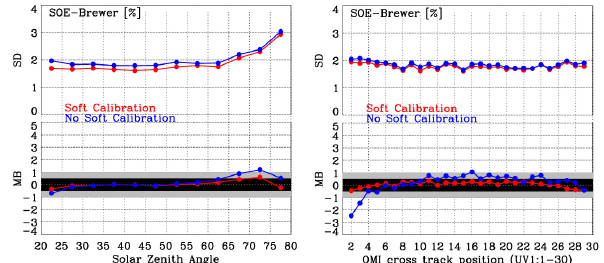
Figure 8. Comparison between the SOE and Brewer total ozone columns with and without soft calibration as a function of solar zenith angle (left) and cross-track position